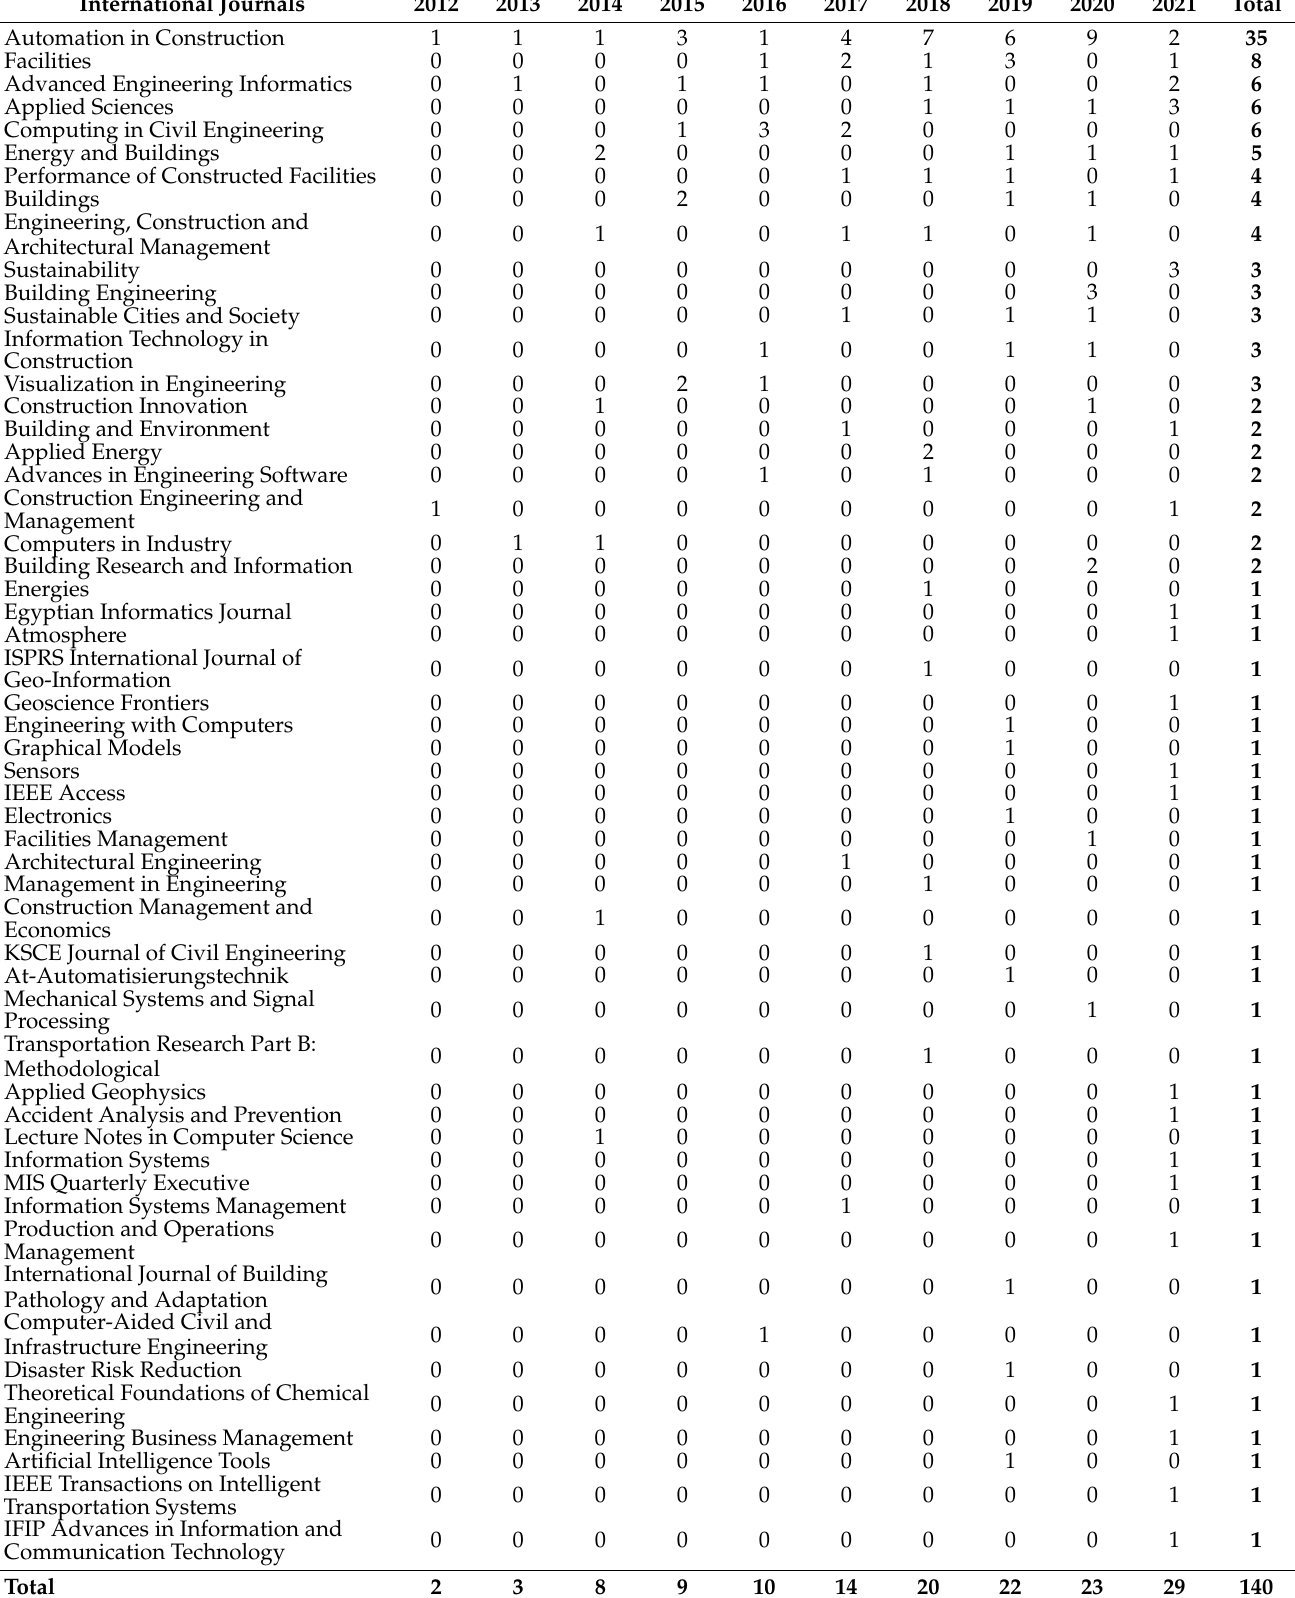
Table 1. Articles published in the last decade on AI applied to FM in the BIM context (List of international